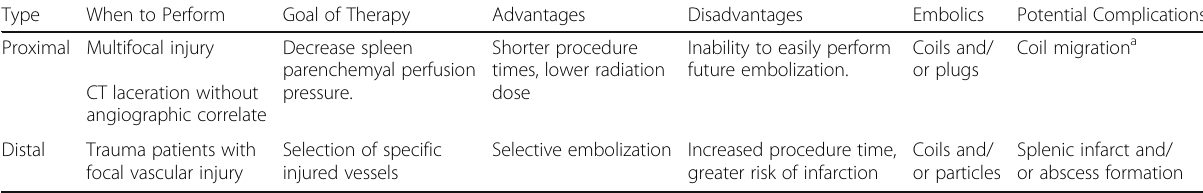
Table 3 Proximal vs Distal Splenic Embolization in Trauma Patients (Ahuja et al. 2015; Imbrogno and Ray 2012; Schnuriger et al. 2011; Killeen et al.